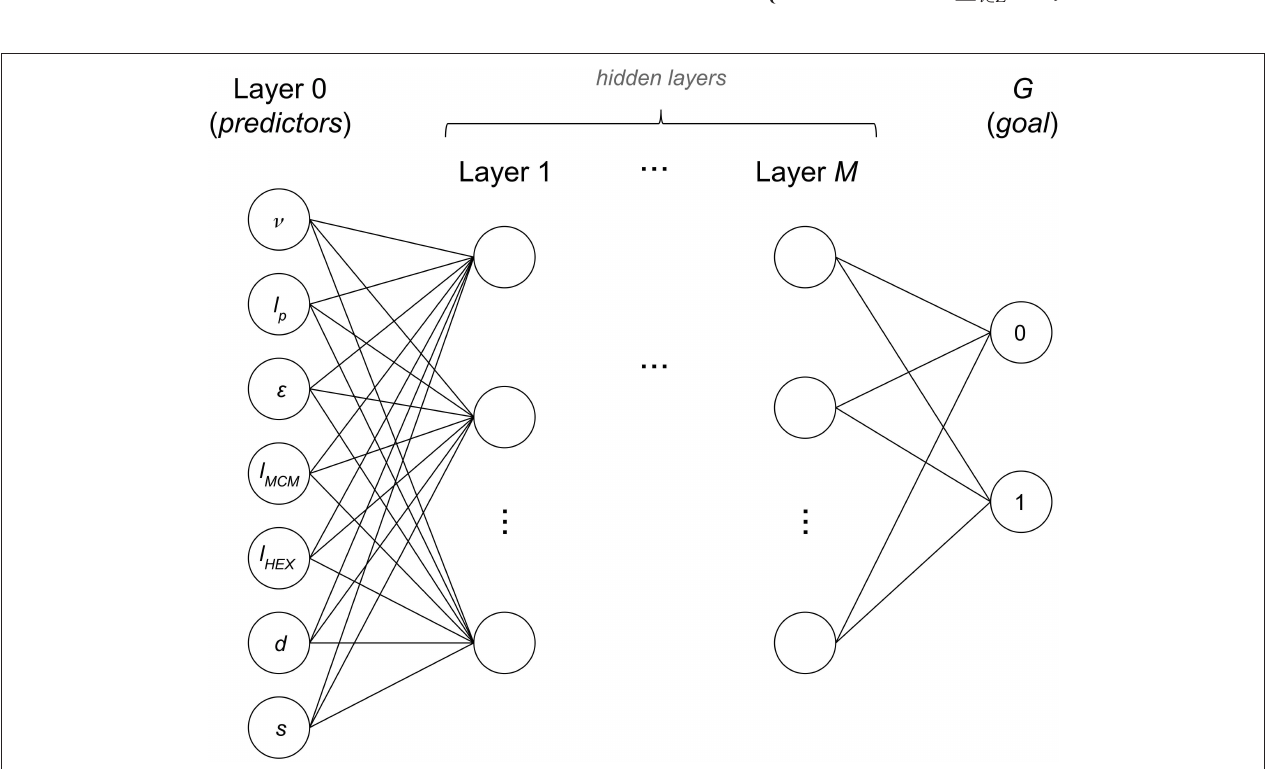
FIGURE 4 | Used multilayer Perceptron model, with M hidden